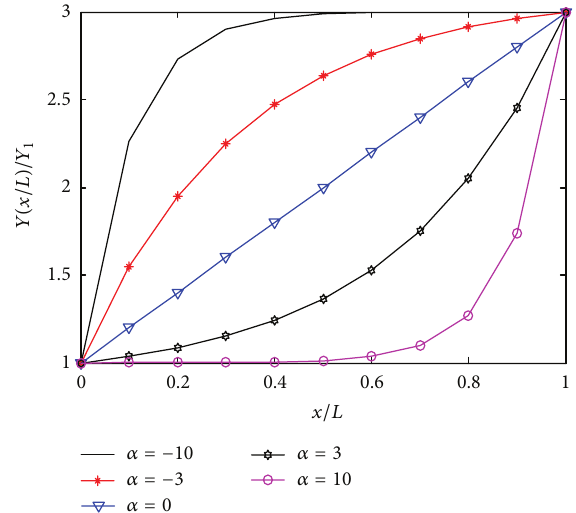
Figure10:Variationofgradationmaterialpropertiesdefinedby(50) with 𝑌 1 = 3𝑌 2